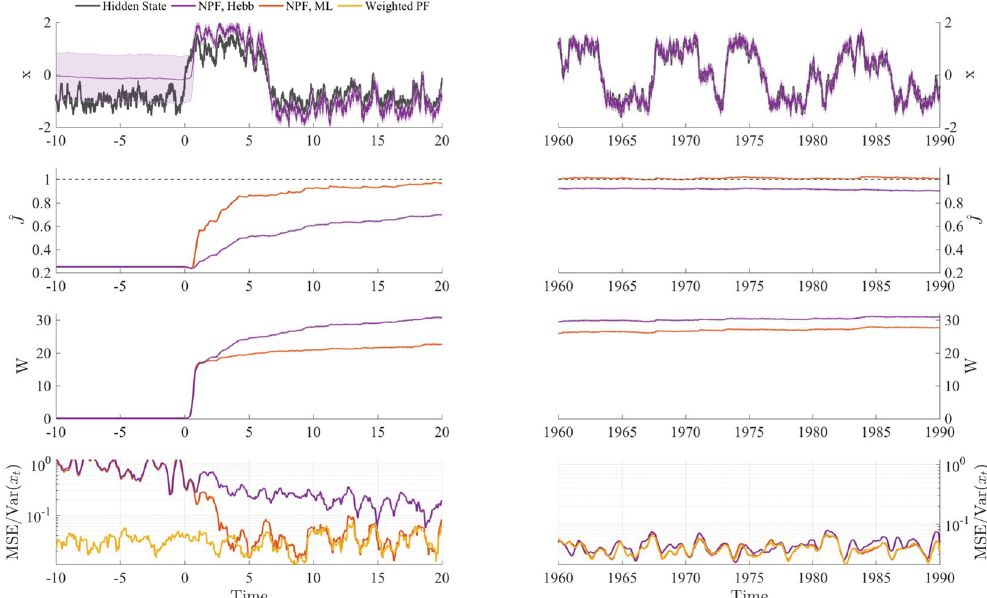
Figure 4. Model parameters are learned by a stochastic gradient ascent on the log likelihood. Simulations shown here correspond to the example model with only a visual cue, i.e. a generative model with Eqs (13) and (15). The generative weight J is learned online either by maximum likelihood (ML, Eq. 10) or the Hebbian learning rule (Hebb) in Eq. (11), which is a valid approximation for small sensory noise. The sensory gain W t is learned online simultaneously, using Eq. (12). As benchmark, we use a weighted PF with the true model parameters. For both parameters W t and J , learning starts at t = 0. As J ˆ approaches the true value J = 1, the trajectory of the filtering neurons (purple) is able to follow that of the true hidden state (black), and the MSE of the NPF resembles that of the standard